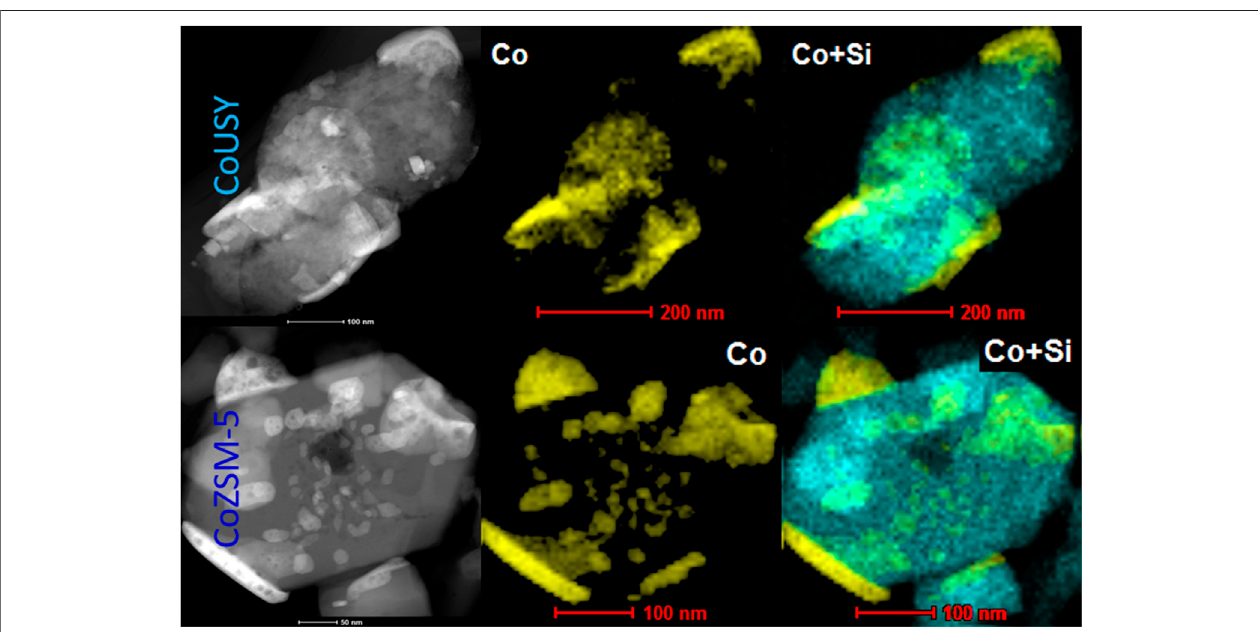
FIGURE 4 | HAADF/STEM images along with EDX maps of Co (yellow) and Si (blue) distributions in the CoUSY and CoZSM-5 catalysts.